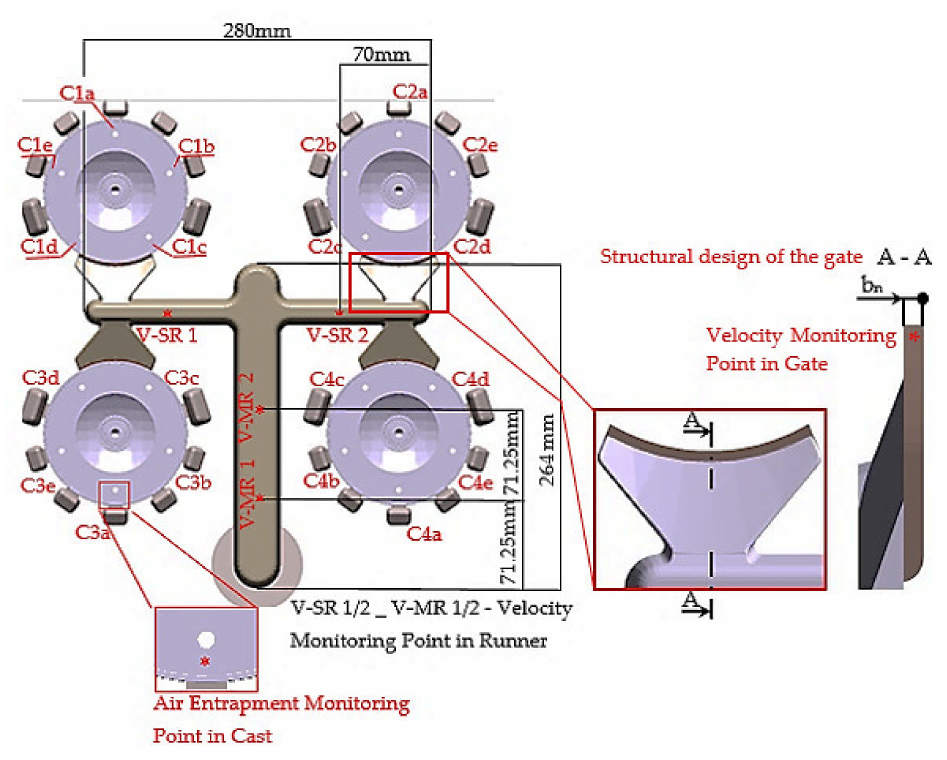
Figure 1. Location of measurement points. Table 1. Gate